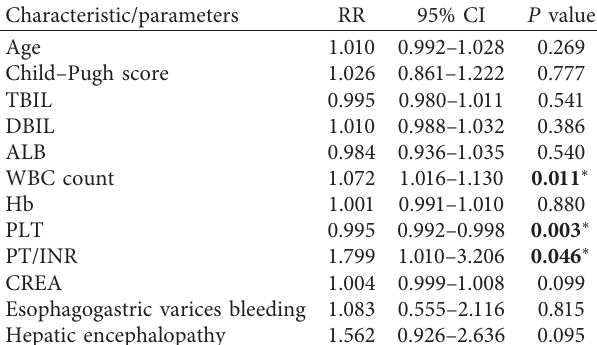
Table 5: Multivariate Cox proportional hazards regression analysis of prognostic factors for overall survival of patients with primary biliary